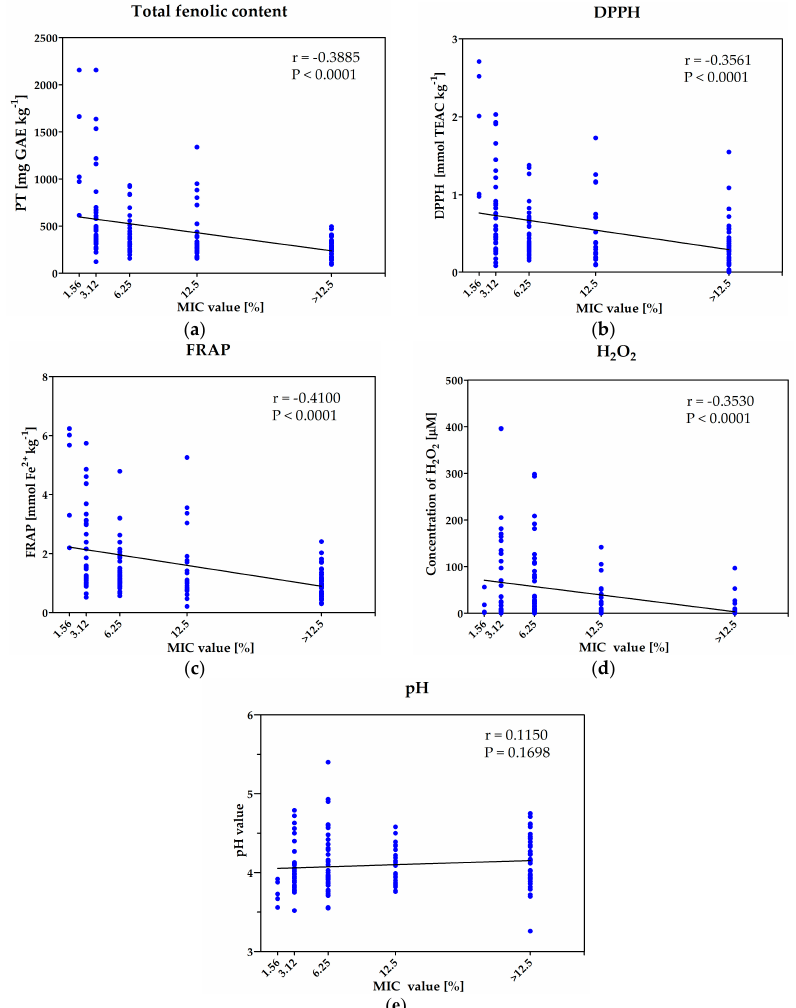
Figure 3. Results of statistical analyses of correlation between antimicrobial activity and some of the investigated parameters: ( a ) total phenolic content; ( b ) antioxidative properties determined with DPPH assay; ( c ) antioxidative properties determined with FRAP assay; ( d ) concentration of generated hydrogen peroxide; ( e ) acidity—pH value.